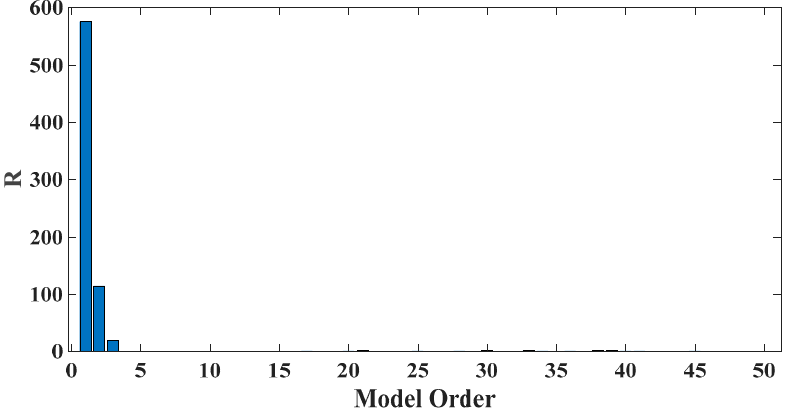
Figure 20. Evaluation index of damage detection results using various AR orders (the case of level 2 damage occurring on the third floor).